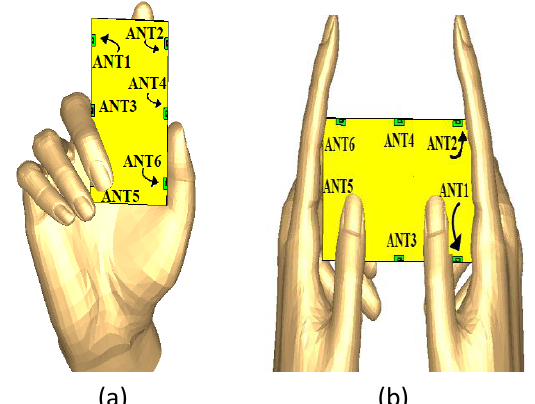
Figure 9. The customer’s hand usage scenarios: ( a ) Single-Hand Operation (SHO) and ( b ) Two-hand Operation